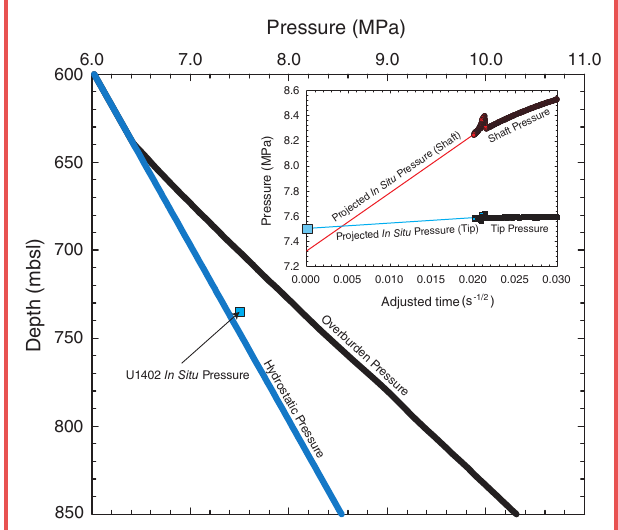
Figure 5. Pressure/stress vs. depth plot at Site U1302. The overburden stress is interpreted from Site 1073 density data (Shipboard Scientific Party, 1998). The in situ pore pressure, as extrapolated from the tip pressure (inset) is interpreted to be 7.54 MPa. Inset: a plot of tip and shaft pressure vs. the inverse square root of time. For both the tip and the shaft pressure, the pressure is extrapolated linearly to zero-time to estimate the in-situ pressure (e.g. Flemings et al.,